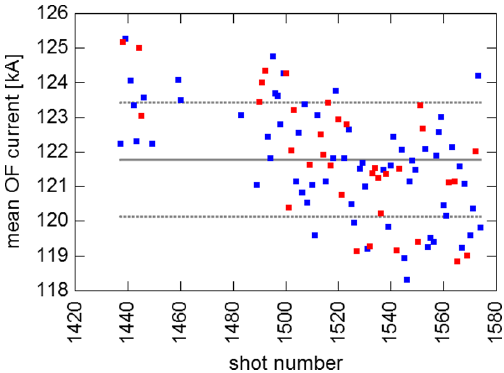
FIG. 10. The magnitude of the OF current at peak power versus shot number. Good shots are shown in blue and poor shots in red. The values shown are averaged over the first 10 ns at peak